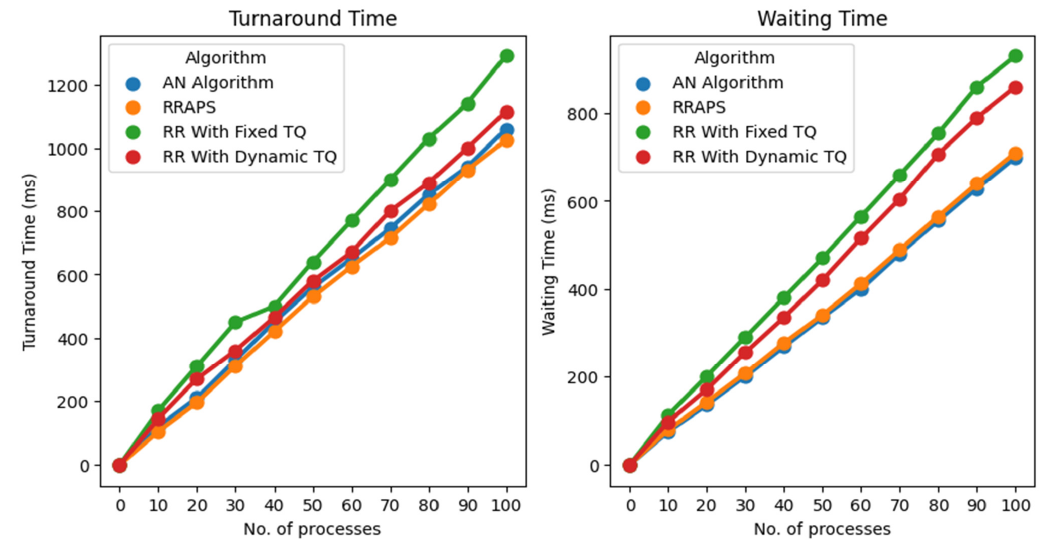
Figure 3. Comparative analysis of turnaround time and waiting time for 100 processes.